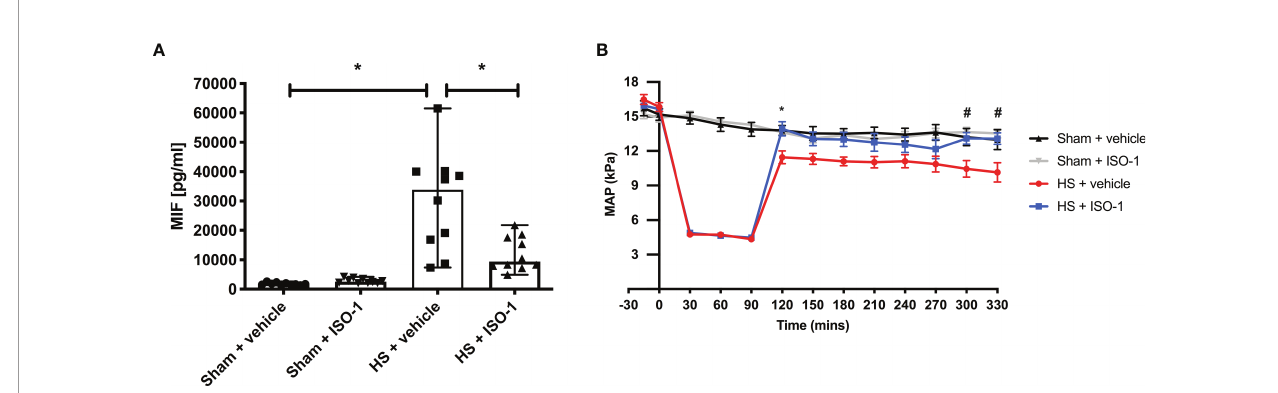
FIGURE 2 | Serum MIF levels are elevated in HS-rats and ISO-1 improves HS-induced circulatory failure in a short-term follow-up acute HS model. (A) Serum MIF levels were detected by ELISA in vehicle or ISO-1 treated rats. Data are expressed as median with range of ten animals per group. (B) Mean arterial pressure (MAP) was measured from the completion of surgery to the termination of the experiment for all groups. Statistical analysis was performed using one-way ANOVA followed by a Bonferroni ’ s post-hoc test. *p < 0.05 Sham + vehicle vs. HS + vehicle; # p < 0.05 HS + vehicle vs. HS +